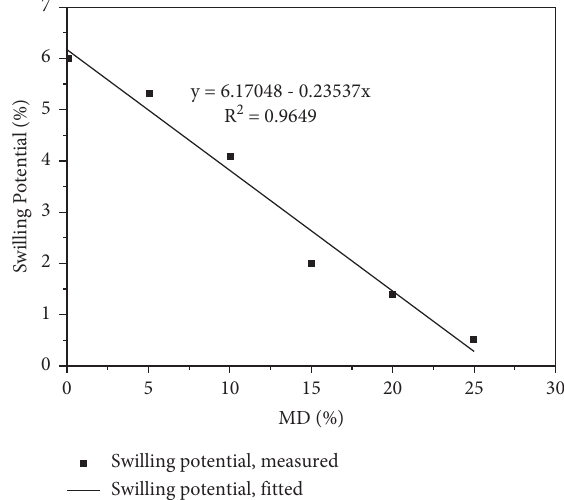
Figure 12: Variation of CBR with different percentages of MD.